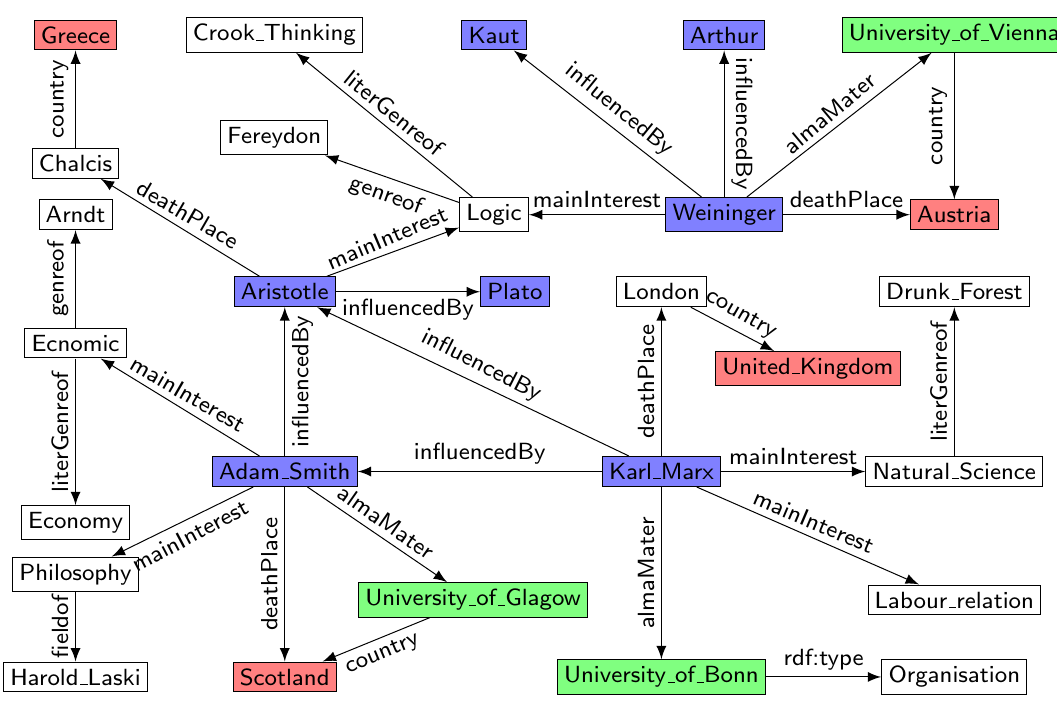
Fig. 1 An example RDF graph G 1 excerpted from DBpedia